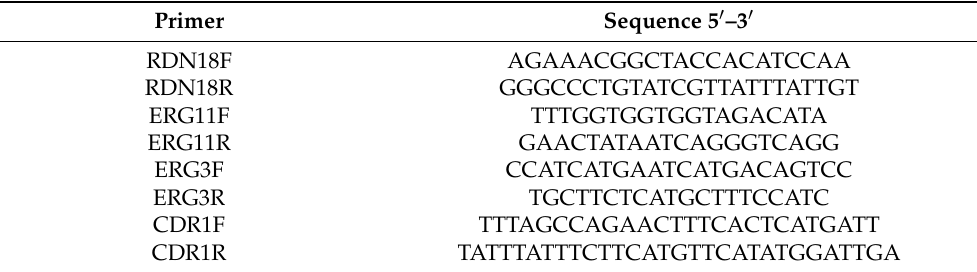
Table 4. Primers used in the